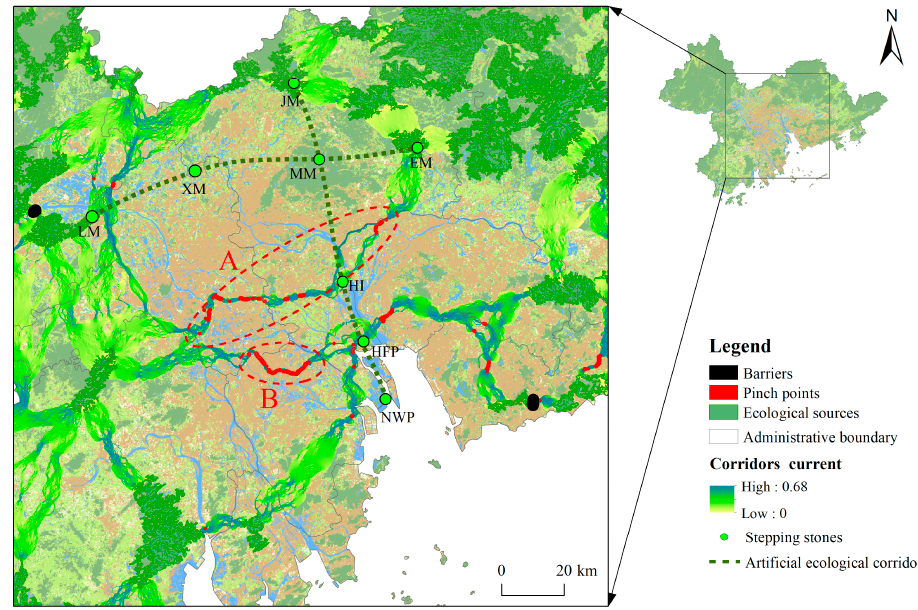
Figure 7. Ecological security patterns and ecological network planning map in key areas.